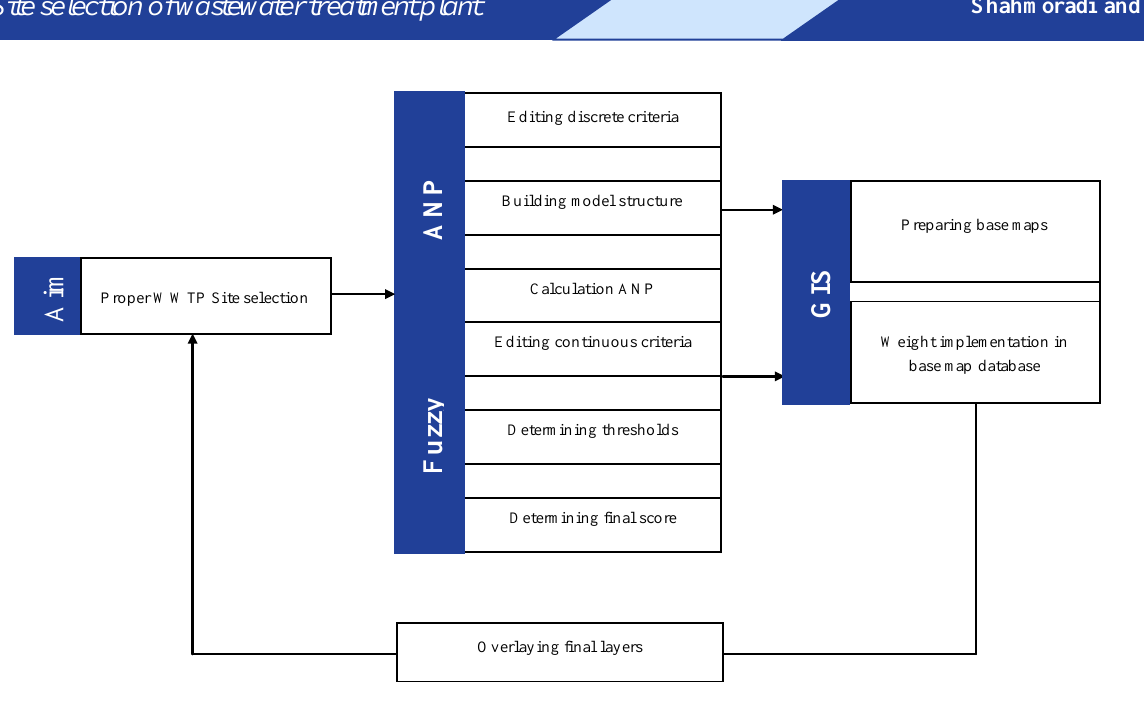
Figure 1. Procedure framework WWTP: wastewater treatment plant; ANP: Analytic network process; GIS: Geographical Information